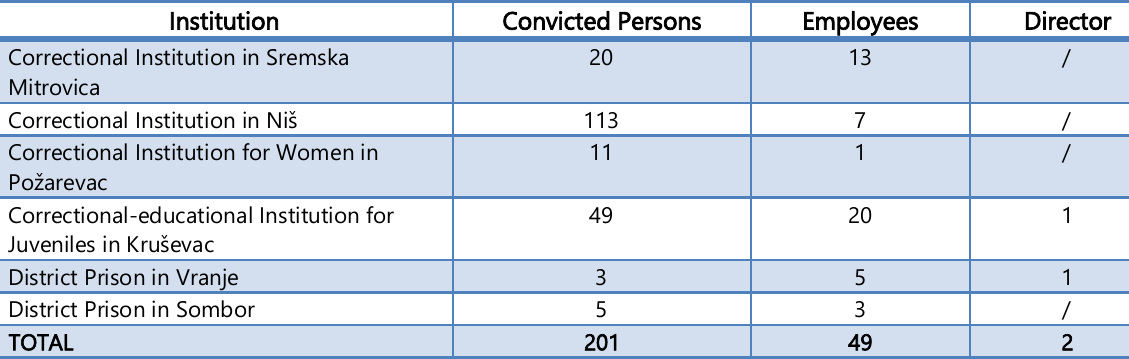
Table 1: Status/Affiliation of Interviewed Persons (Source: Author‟s depiction) Institution